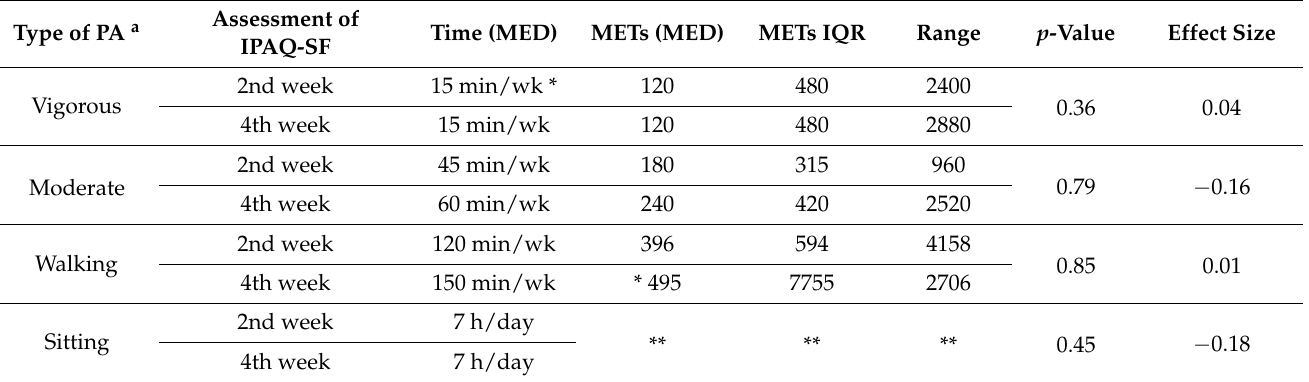
Table 3. Differences between the interim assessment during Tele-Physical Activity promotion